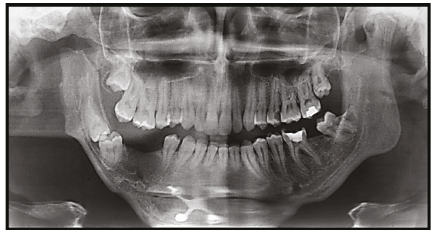
Figure 18: Panoramic radiography after two years emphasizing stability in the chin fi xation and with no signs of ankylosis relapse.